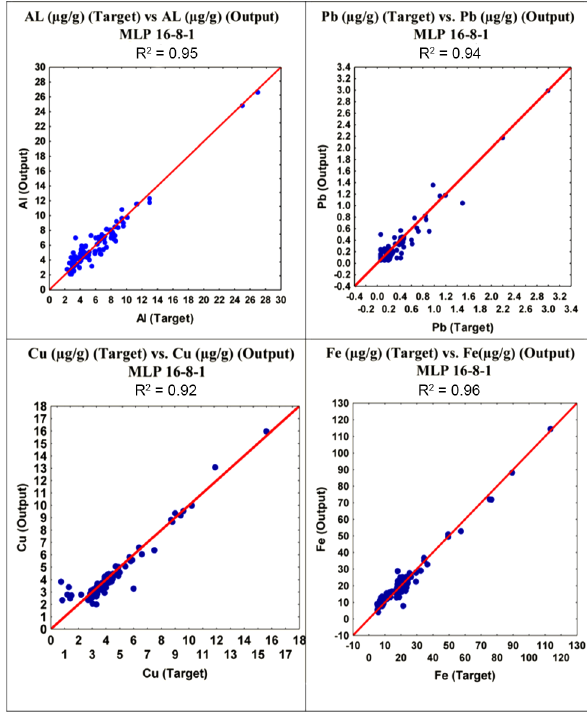
Figure 7. Shows the relation between the observed values and the ANN model’s estimated values for the four heavy metals